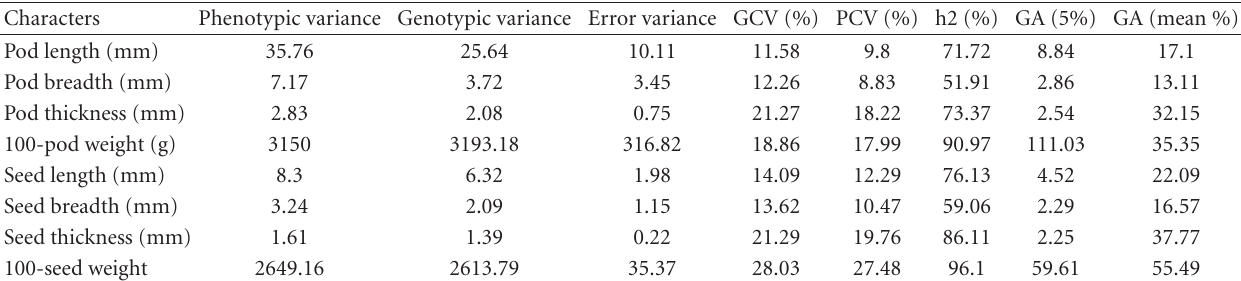
Table 4: Phenotypic and genotypic analysis of pod and seed characters of P. pinnata .